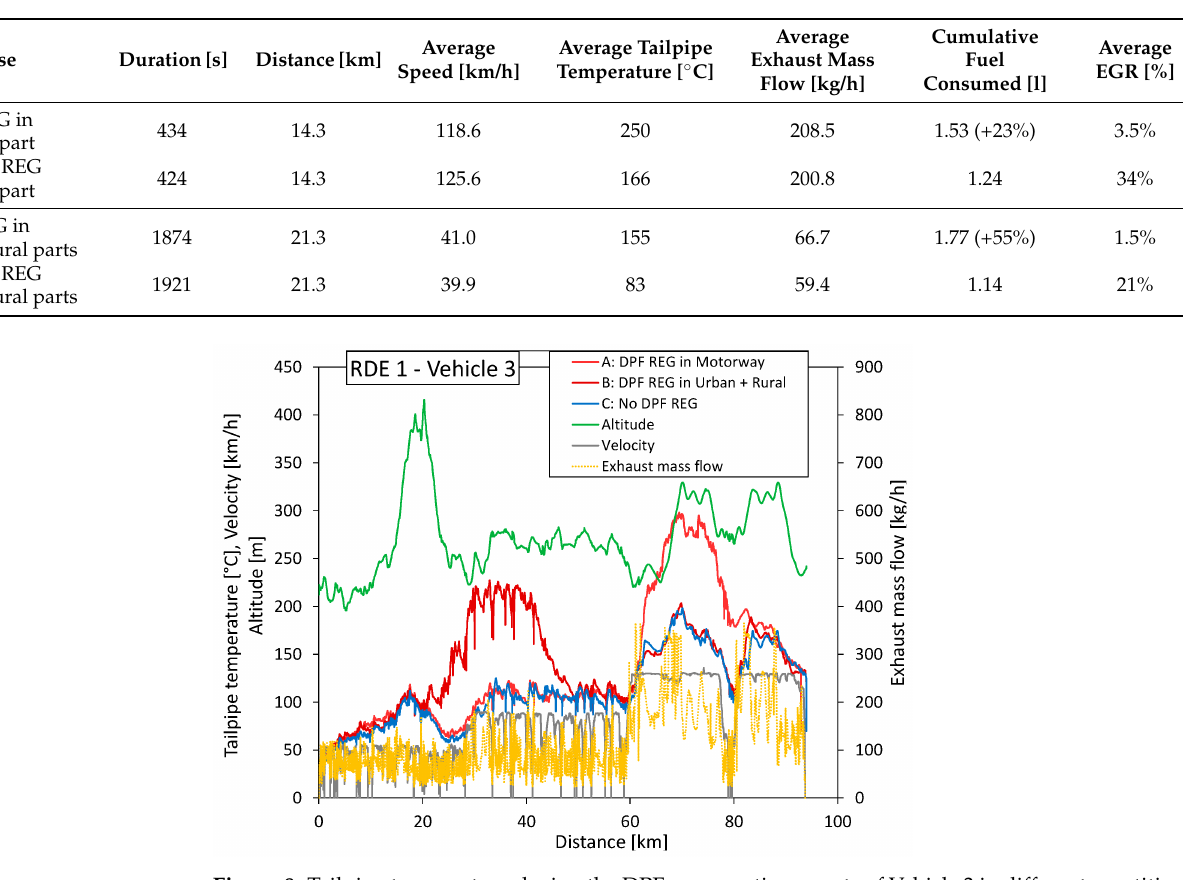
Table 4. Conditions during the DPF regeneration events of Vehicle 3 in different repetitions of the RDE 1 profile.